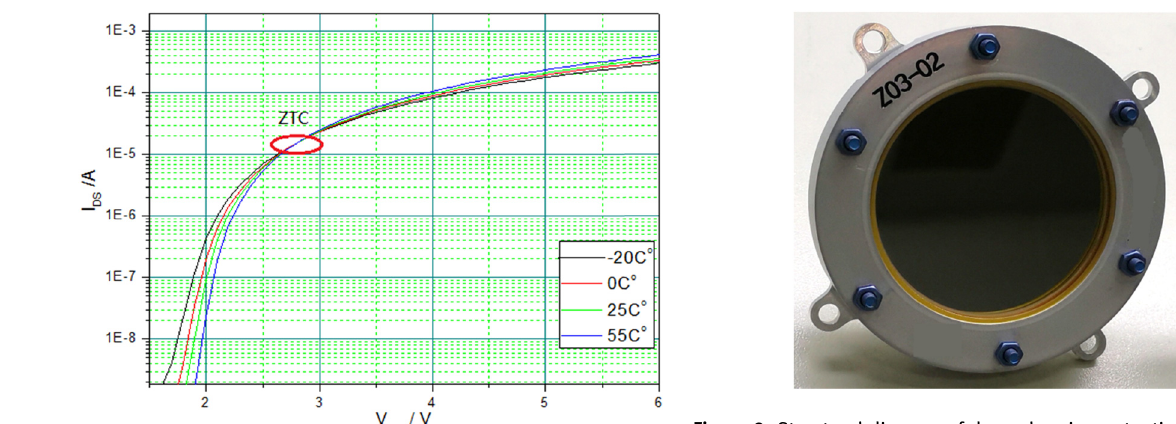
Figure 9: Structural diagram of deep charging potential sensor.